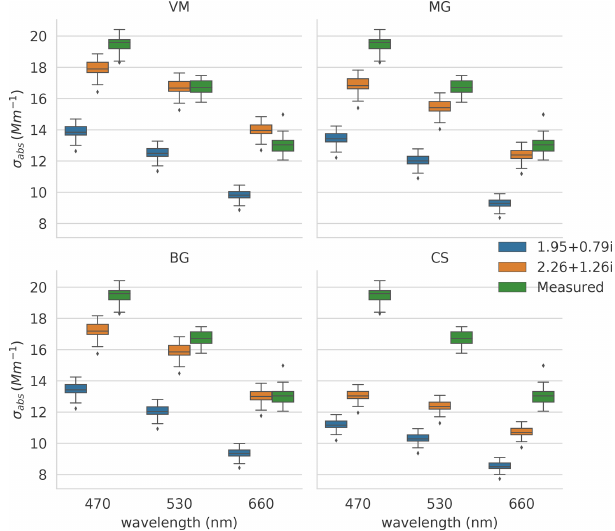
Figure 3. Modelled (blue and orange markers) and measured (green markers) absorption coefficients ( σ abs ) at PSAP wavelengths for RF06_1. Variables are modelled with two m BC values (shown in the legend) using the CS, MG, BG, and VM models (specified on the top of each plot). OA is assumed to be non-absorbing with the refractive index m OA of 1 . 55 + 0 i . The horizontal lines in the boxes represent the median value, the boxes represent the 25th to 75th per- centile, the whiskers represent 1.5 times the interquartile range, and the diamonds represent outliers.